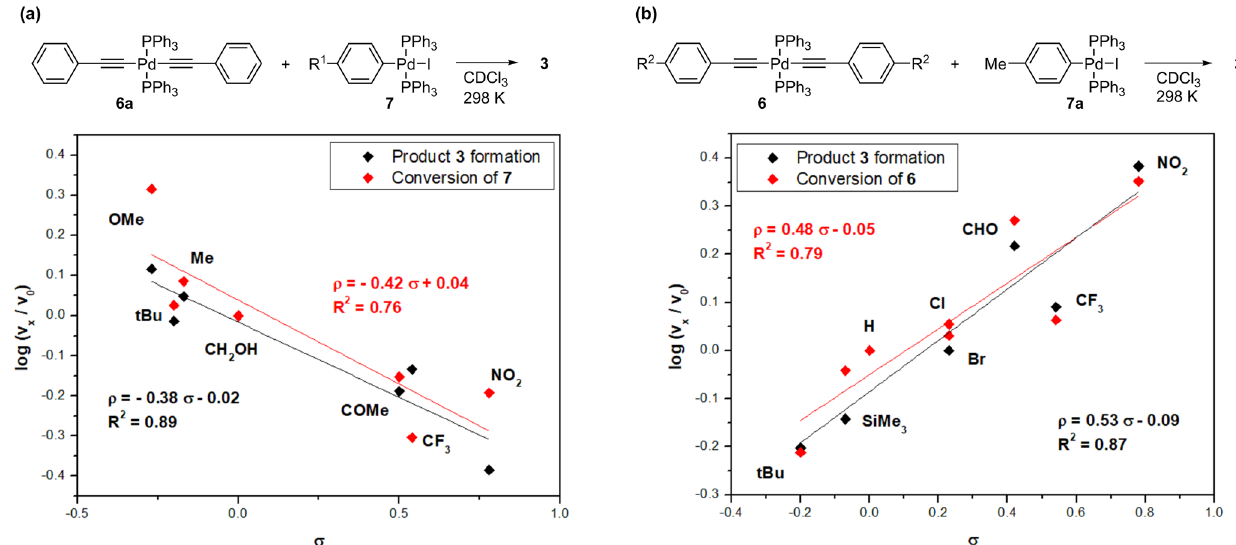
Fig. 8 Hammett plots for the transmetallation reactions of 6 and 7. a Reaction of 6a with para -substituted oxidative addition complexes 7 . Conditions: 6a (0.011 M), 7 (0.01 M), CDCl 3 , 302 K. b Reaction of 7a with p -substituted palladium bisacetylides 6 . Conditions: 6 (0.01M), 7a (0.011 M), CDCl 3 , 302 K. For Hammett plots using σ p + ( σ p - ) constants, see Supplementary Figs.